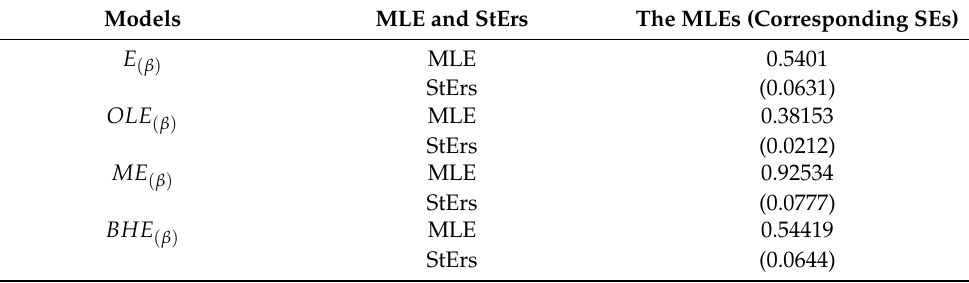
Table 8. MLEs, StErs, and CIs for the survival times Table 6. MLEs and SE for the relief times data. Table 6. MLEs and SE for the relief times data.